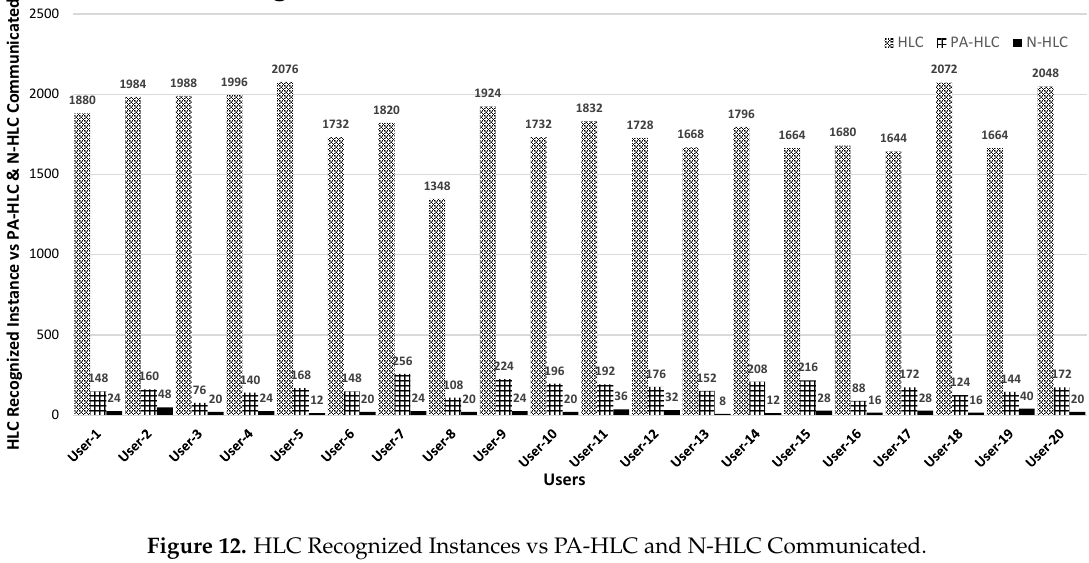
Figure 12. HLC Recognized Instances vs PA-HLC and N-HLC